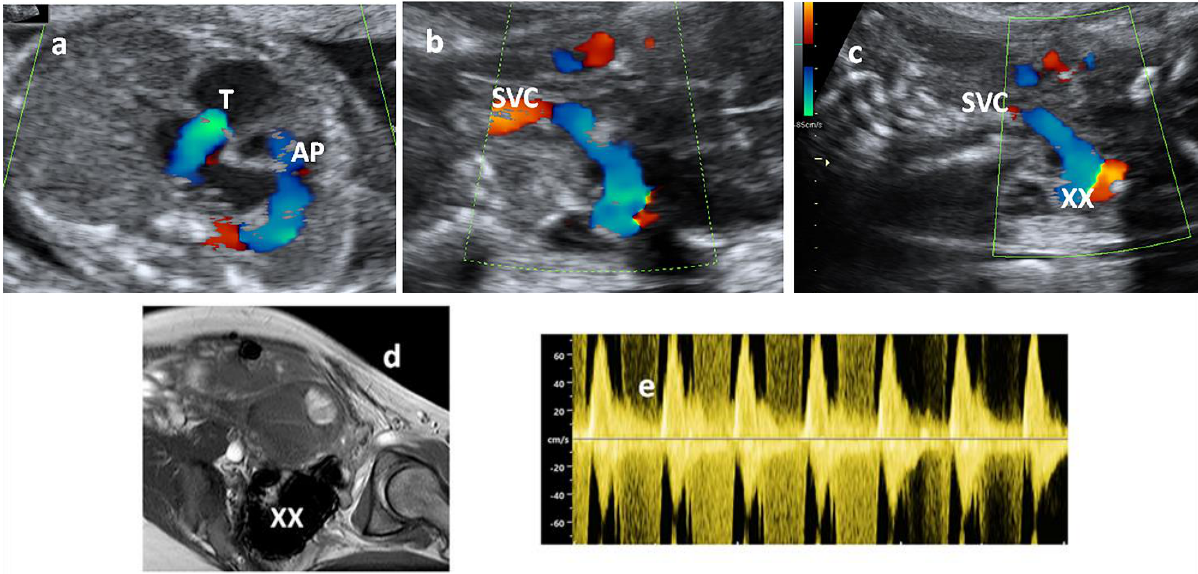
Figure 1. ( a ) Fetal echocardiography—showing tricuspid regurgitation (T) and normal pulmonary artery anterograde flow (AP); ( b , c ) Color Doppler flow of the superior caval vein (SVC) proceeding toward the head to an enlarged zone (XX); ( d ) MRI image of the aneurysmatic occipital area (XX); ( e ) Echo Doppler showing systodiastolic flow in this area. Supplementary Video showing the flow (via color Doppler imaging) passing from superior caval vein (SVC) to the lateral part of the